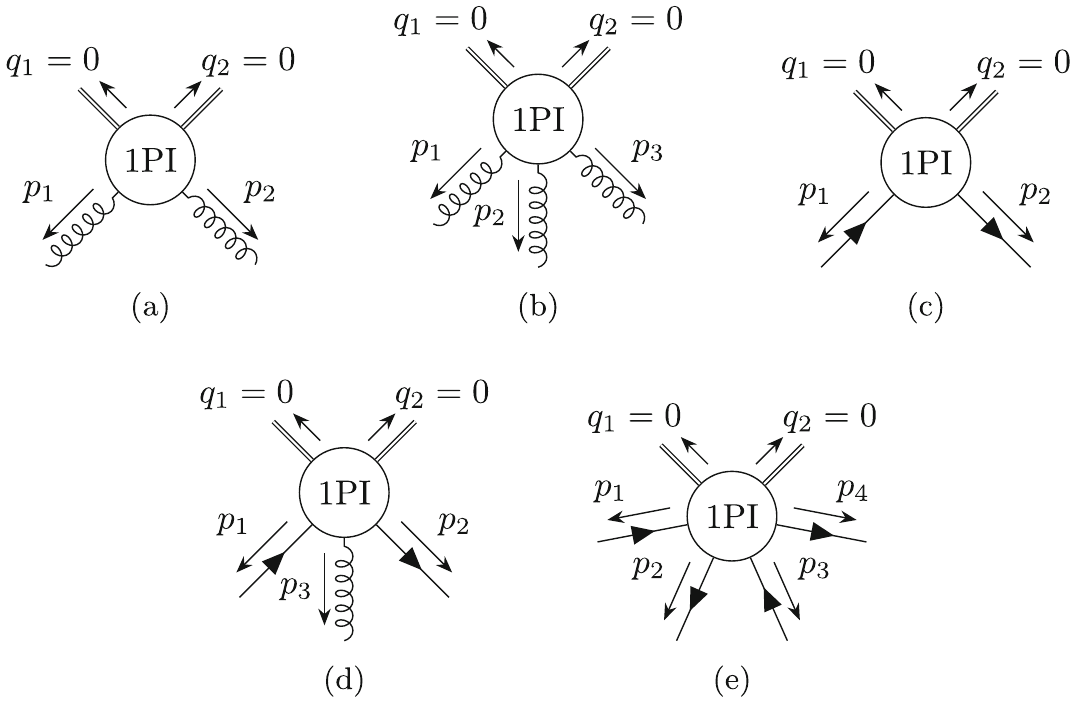
Fig. 2 Graphical representation of all considered 1PI graphs when renormalising the UV poles arising from contact interactions of double operator insertions. Each operator is again inserted via an “anchor” field, which is indicated via the double line. Both insertions are at zero momentum q 1 = q 2 =